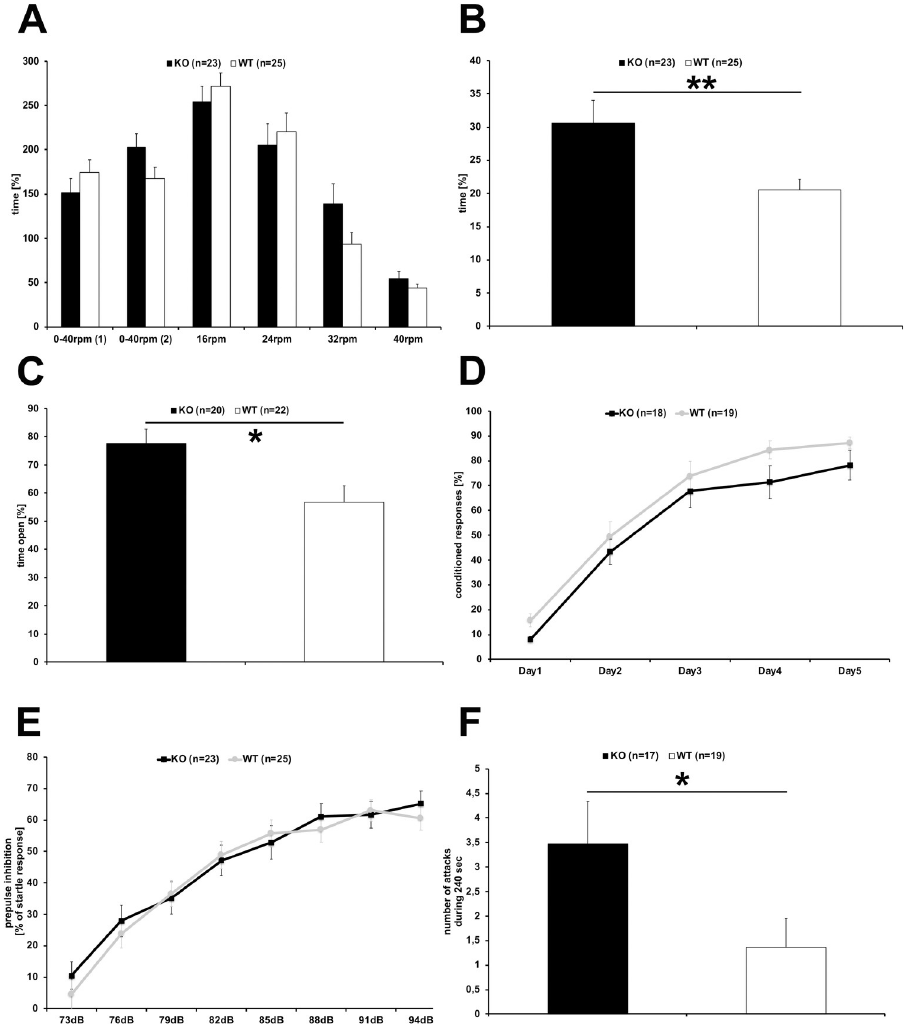
Fig 1. Behavioral assessment of BT-IgSF-deficient mice. BT-IgSF-deficient mice and control wildtype littermates were subjected to a series of behavioral paradigms. Motor coordination tested on the rotarod (A) did not differ between BT-IgSF-deficient (black columns) and control mice (white columns). In the open field (B) BT-IgSF-deficient mice (black column) stayed significantly longer in the center compared to their wild-type littermates (white column). In the O-Maze (C) BT-IgSF-deficient mice (black columns) spend more time in the open areas compared to littermate controls (white column). In the two-way active avoidance shuttle box paradigm (D) BT-IgSF-deficient (black line) and control mice (grey line) showed similar acquisition of the task as measured by conditioned responses indicating normal associative learning. Prepulse inhibition of the startle response (E) was not affected in BT-IgSF-deficient mice (black squares) in comparison to wild type littermates (grey bullets). Male BT-IgSF-deficient mice (black column) displayed increased aggression in the intruder test (F) compared to controls (white column) measured by the number of